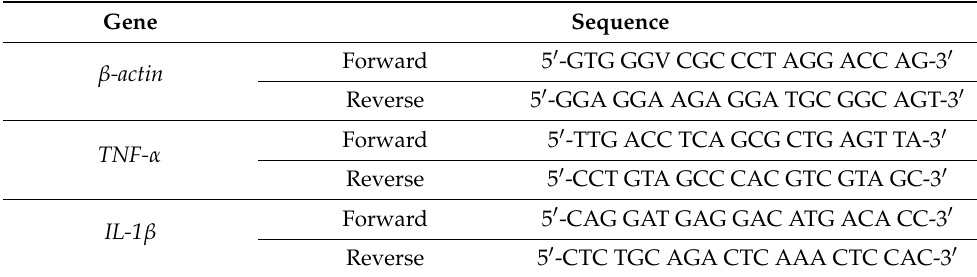
Table 1. Primers used for real-time PCR.